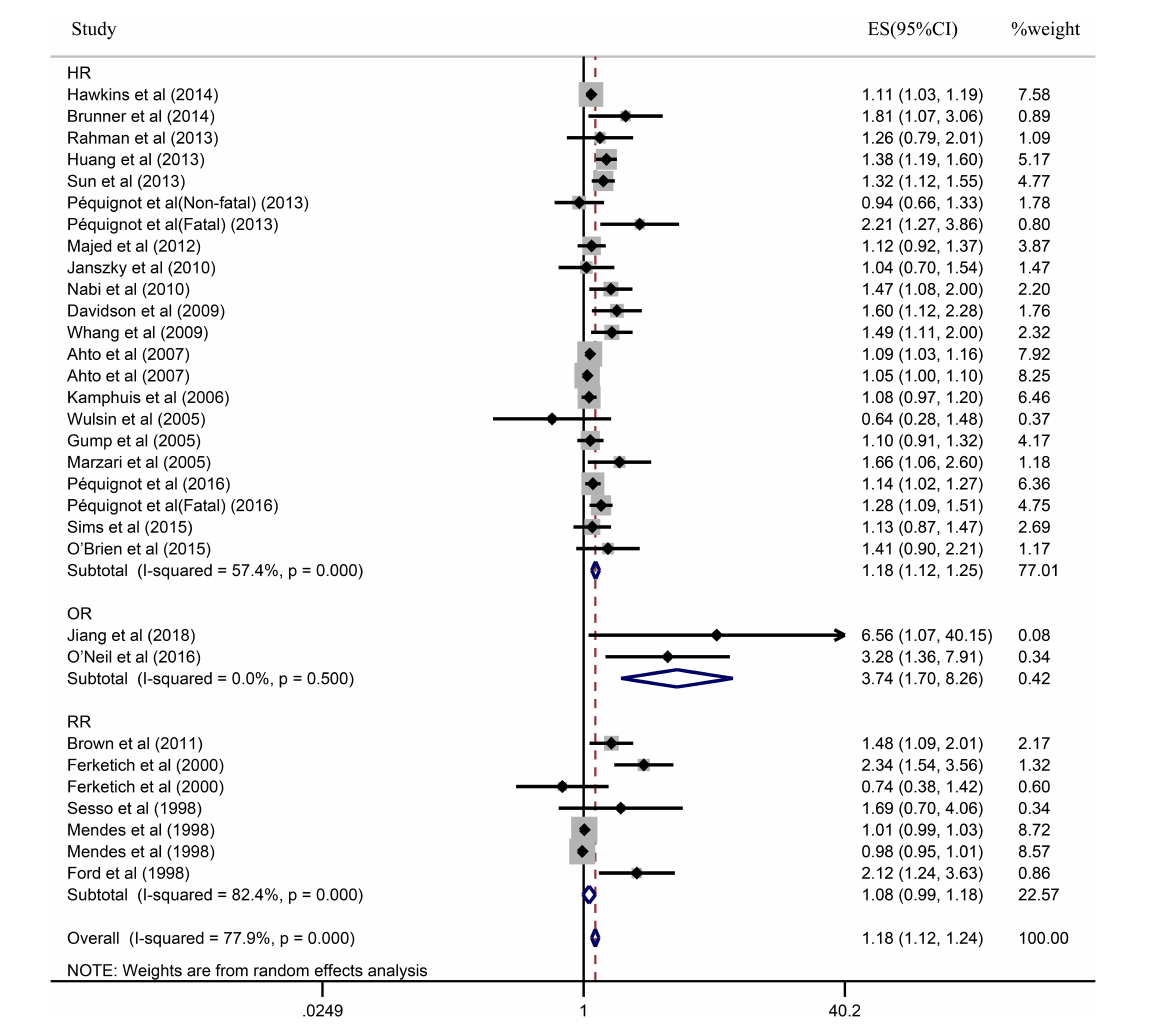
FIGURE6 Subgroup analysis with evaluation index (HR, OR, or RR) presents the association between depression and the risk of coronary heart disease in a prospective cohort